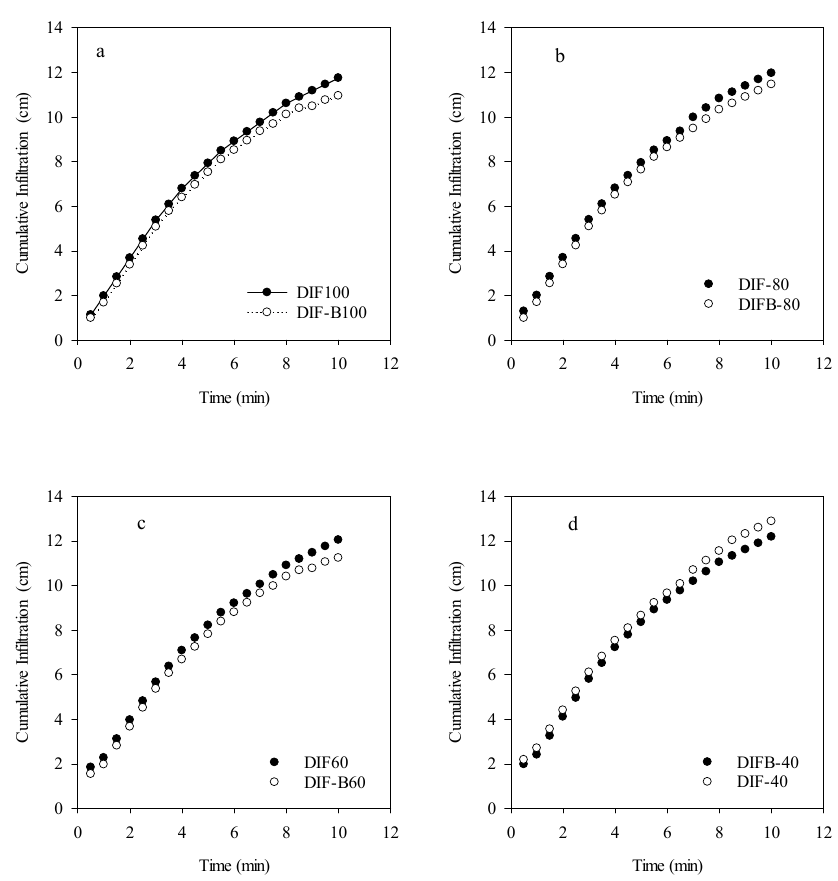
Figure 5. Cumulative infiltration of fresh water under deficit irrigation with and without biochar, where ( a ) 100%, ( b ) 80%, ( c ) 60%, and ( d ) 40% of ETc.